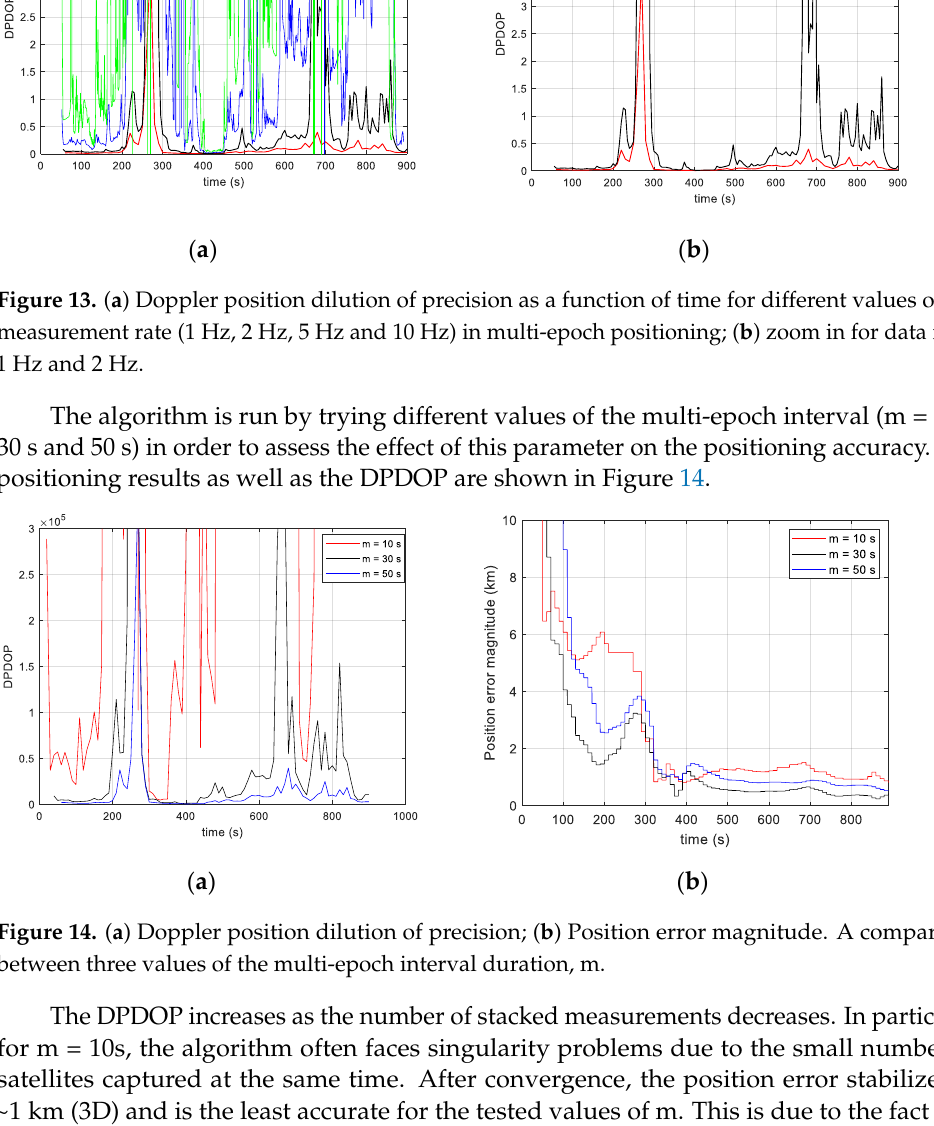
between three values of the multi-epoch interval duration, m.